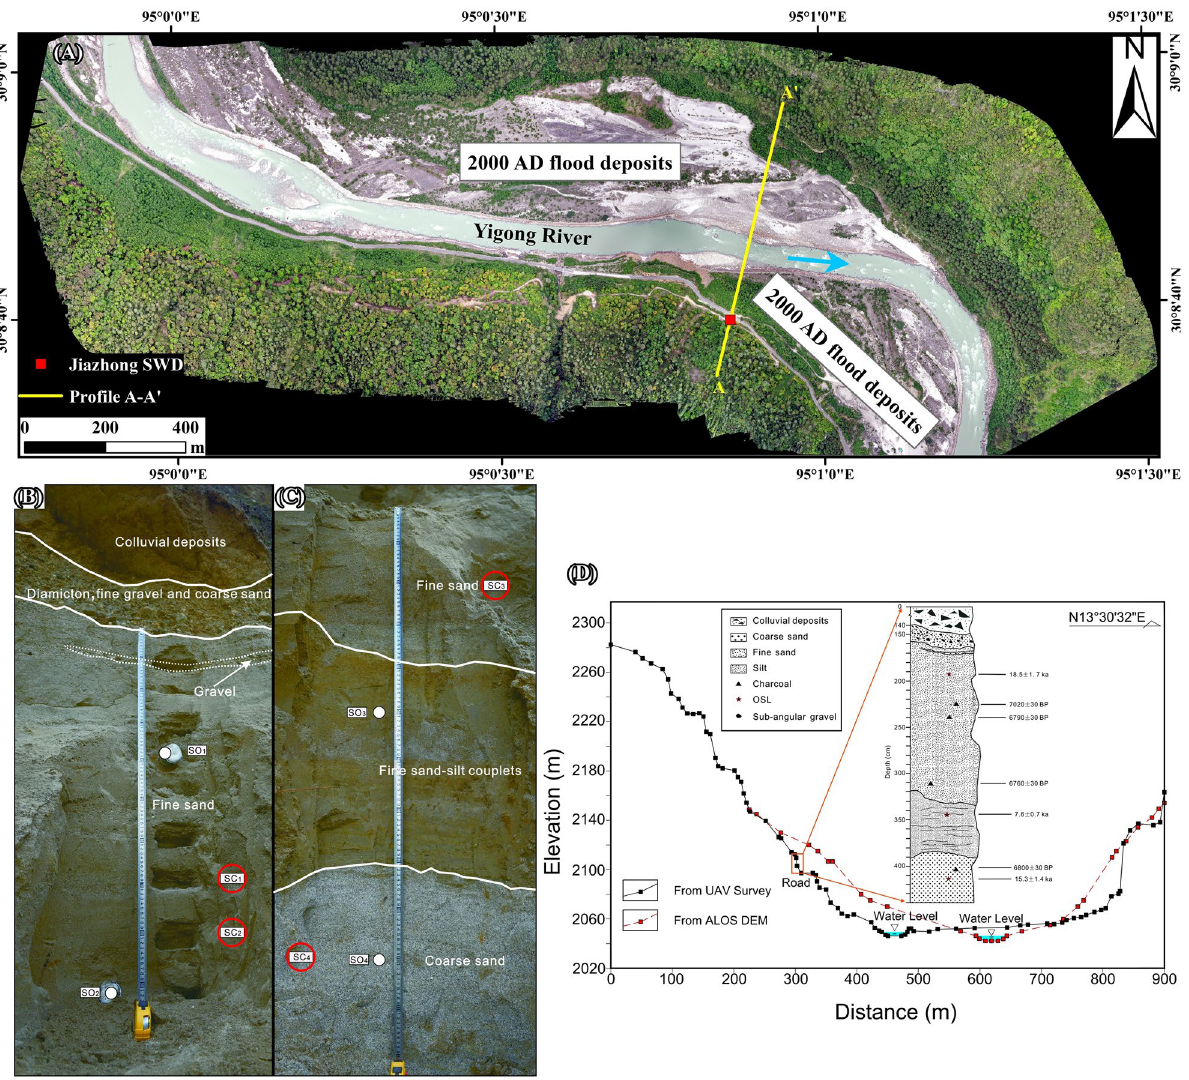
Figure 2. ( A ) Location of slackwater deposits (SWDs) at Shuangyu Village. Orthographic image taken on May 11, 2020, by the Dajiang unmanned aerial vehicle (UAV); ( B ) upper part of sedimentary section; ( C ) lower part of sedimentary section. The total thickness of the section is 2.6 m. SO1 to SO4 denotes luminescence dating samples and SC1 to SC4 denotes radiocarbon dating samples; ( D ) cross-section and sedimentary sequence